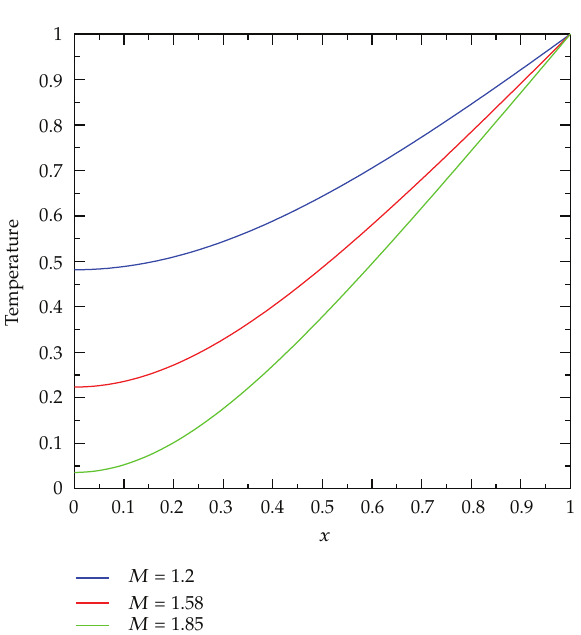
Figure 2: Temperature profile in a fin with varying values of the thermogeometric fin parameter. Here, p is fixed at unity.